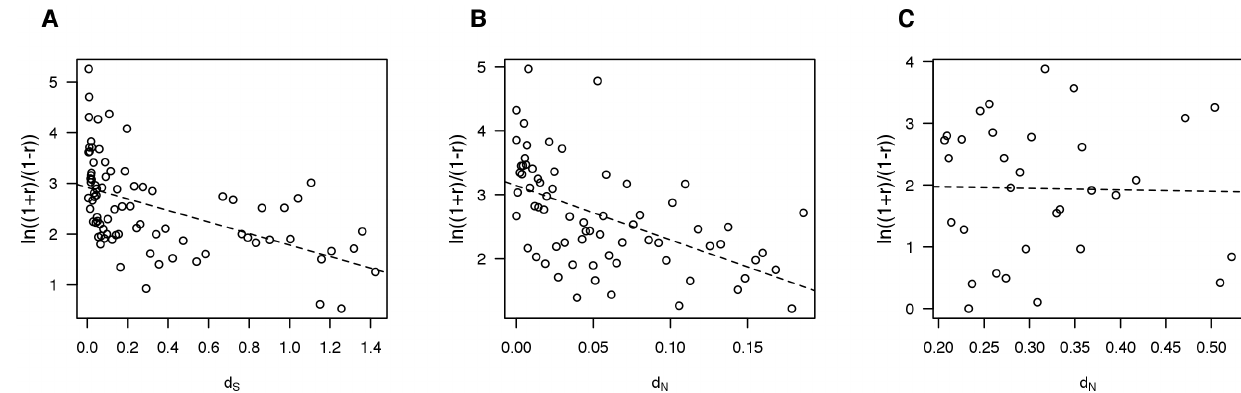
Figure 3. The relationship between Pearson’s correlation coefficient of gene expression and sequence divergence. (A) A significant negative correlation implies a positive correlation between d s and expression divergence because 1 { r can be regarded as expression divergence. Each point represents five gene pairs. (B) A negative correlation between transformed r and d N with d N ƒ 0 : 2 . Each point represents five gene pairs. (C) No correlation between transformed r and d N with d N w 0 : 2 . Each point represents five gene pairs.